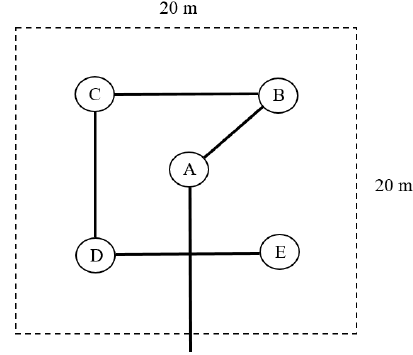
Figure 2. Sampling approach for each elementary sampling unit (ESU).